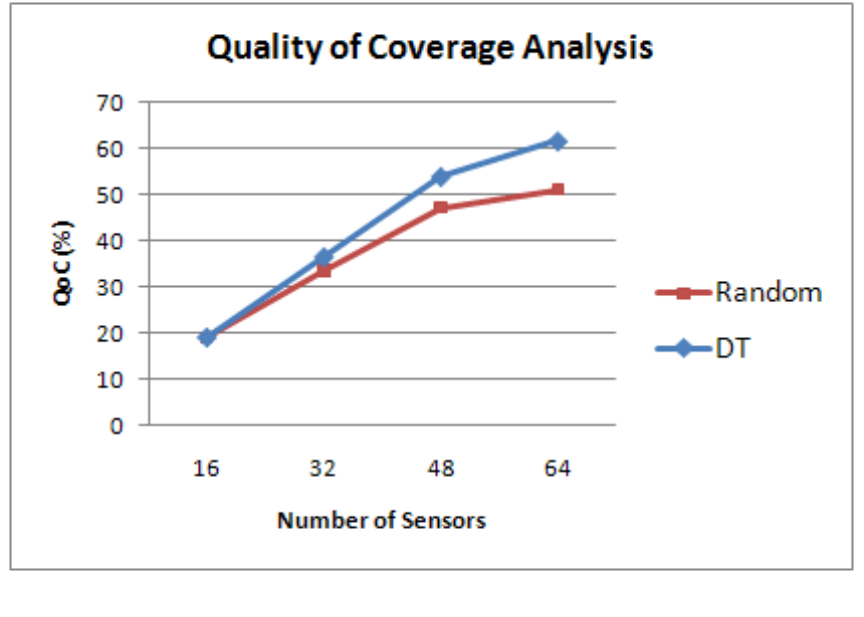
Figure 6. QoC results for random deployment strategy and Delaunay triangulation